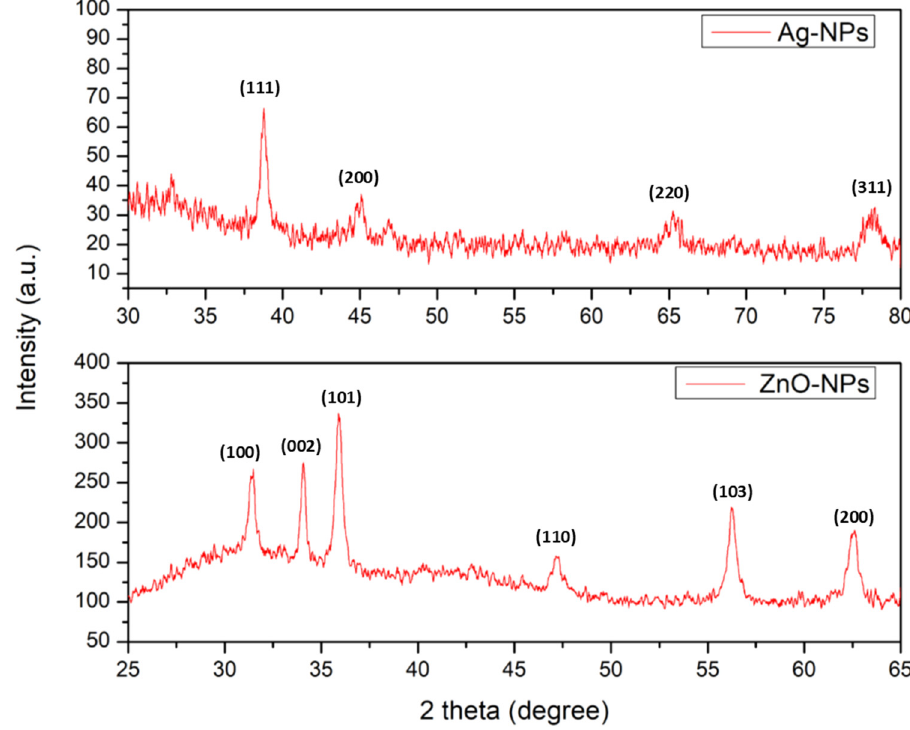
Figure 4: XRD analysis of Ag - NPs and ZnO - NPs.